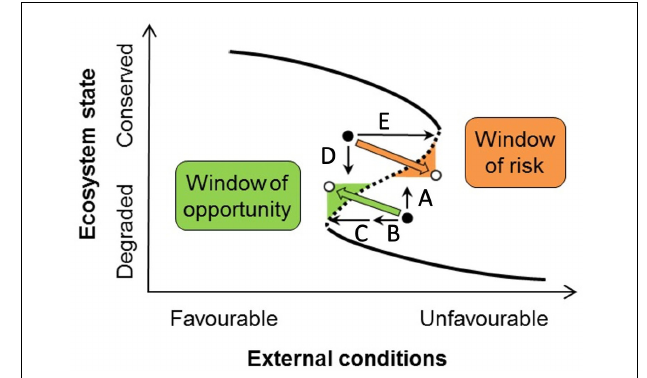
FIGURE 8 | Windows of opportunity and risk (see Figure 1 for explanation of the concept of catastrophic shifts). Arrows exemplify effects of different types of management practices and external climate drivers: A, seeding; B, reduced grazing pressure; C, extremely wet episode; D, deforestation; E, drought (adapted from Sietz et al.,